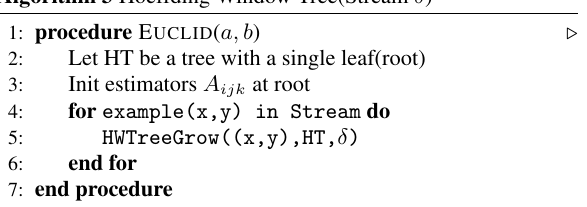
Algorithm 3 Hoeffding Window Tree(Stream δ )